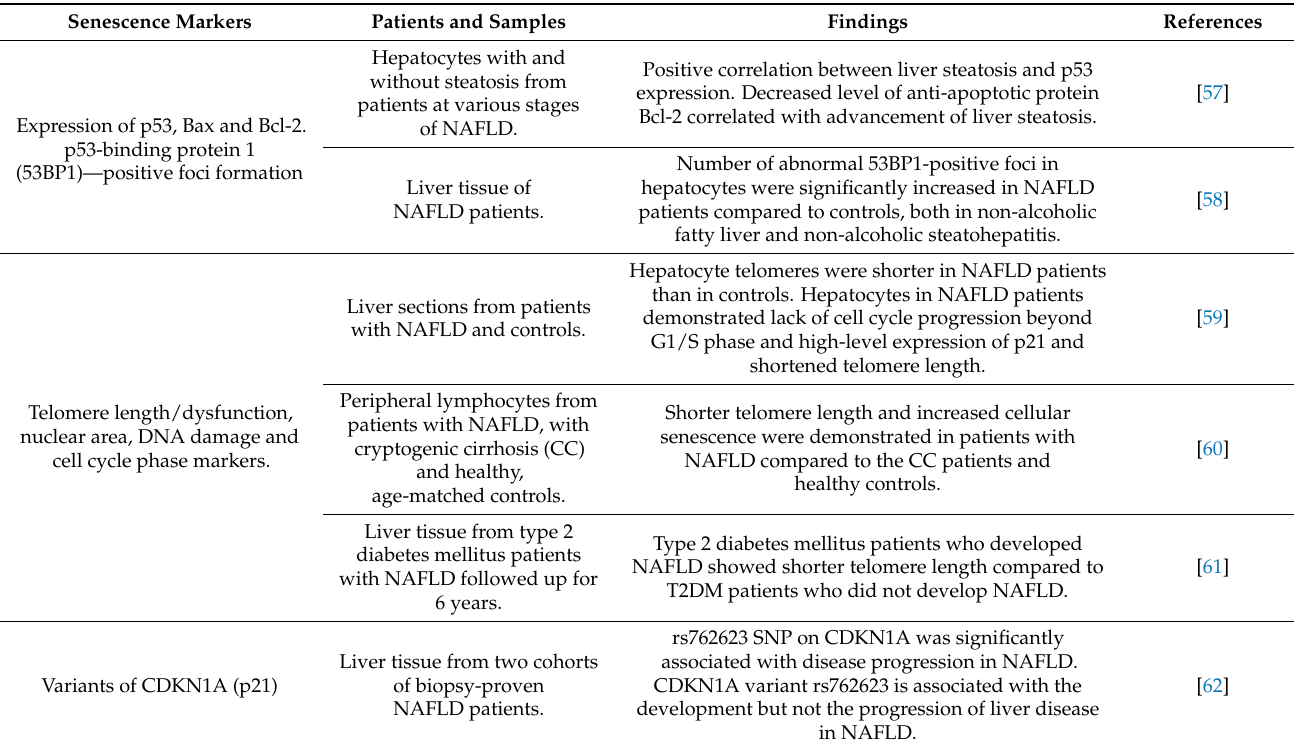
Table 1. Relevant Human studies reporting a positive correlation between senescence and NAFLD development and/or progression, categorized according to used senescence markers. Senescence Markers Patients and Samples